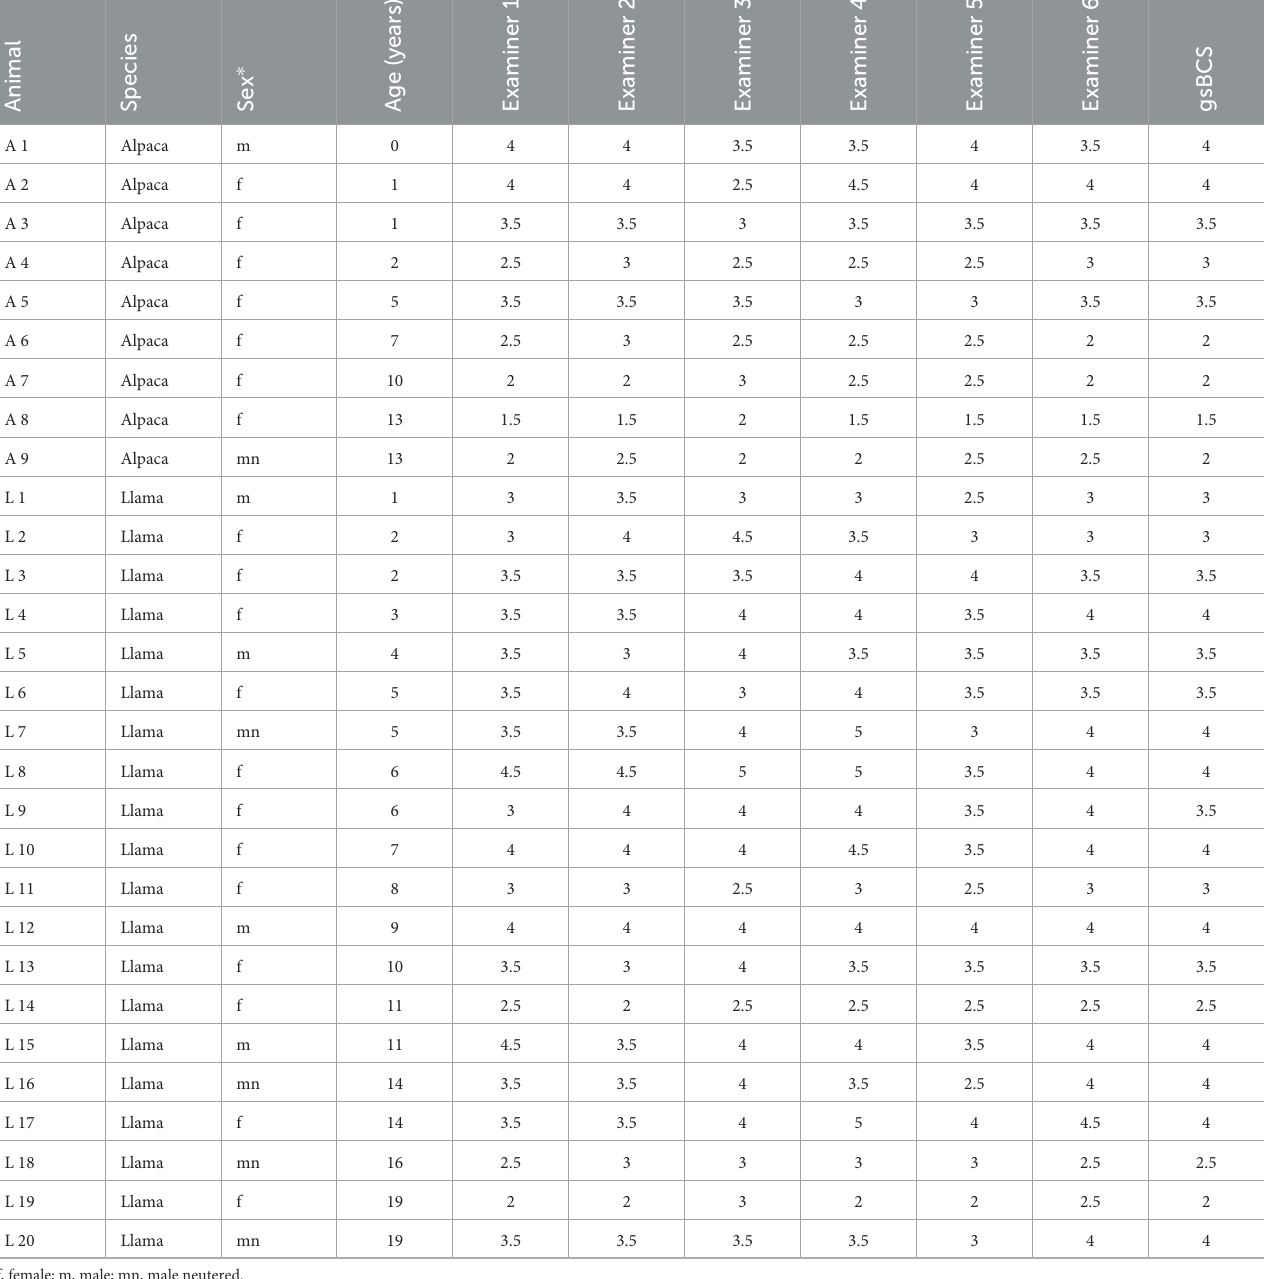
TABLE 1 Overview of sex, age, assessed Body Condition Score (BCS) by each examiner, and calculated gsBCS (gold standard BCS) of the examined alpacas and llamas.